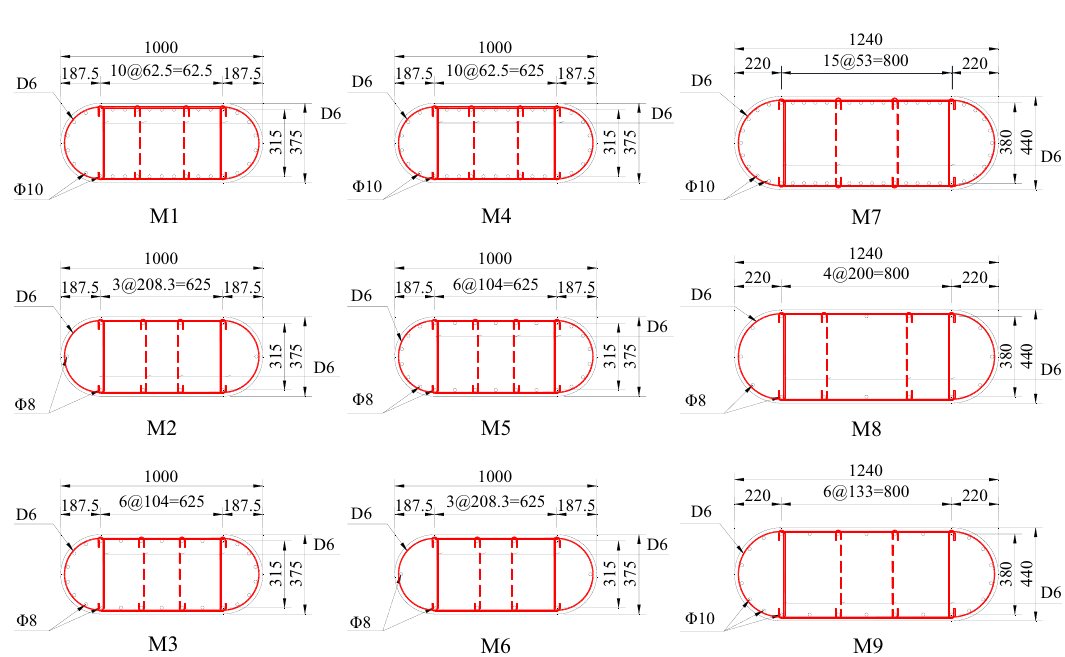
Figure 5. Cross-section and reinforcement arrangement of the RERSCSS concrete piers used in the HSRB test model (Note: 1. M-1–M-9 is the sample number; 2. dimension in the drawing is in cm, and the reinforcement diameter is in mm; 3. D in the picture represents HPB 235 reinforcement, and Ф serves HRB 335